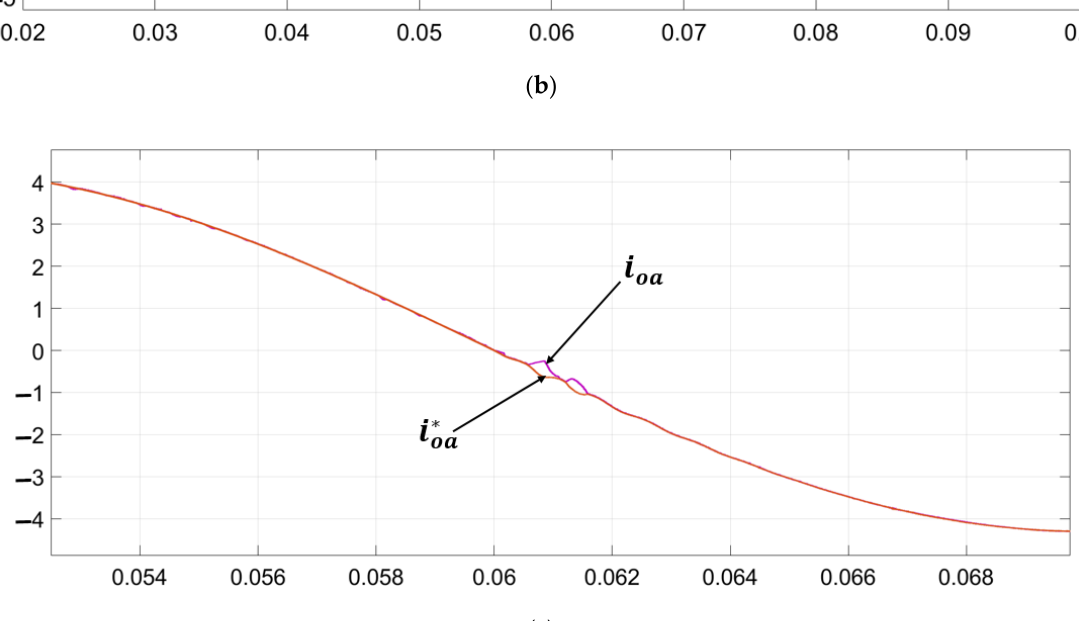
Figure 8. Simulation results of the VMMPC for the TSMC, and output-current frequency reference is set to 25 Hz: The IFRS is added at t = 0.06 s, x axis unit second: ( a ) source voltage V sA /13 V, source current i sA A and source-current reference i sA * A; ( b ) output current i oa A and output-current reference i oa * A; ( c ) details of the box in Figure 8b.